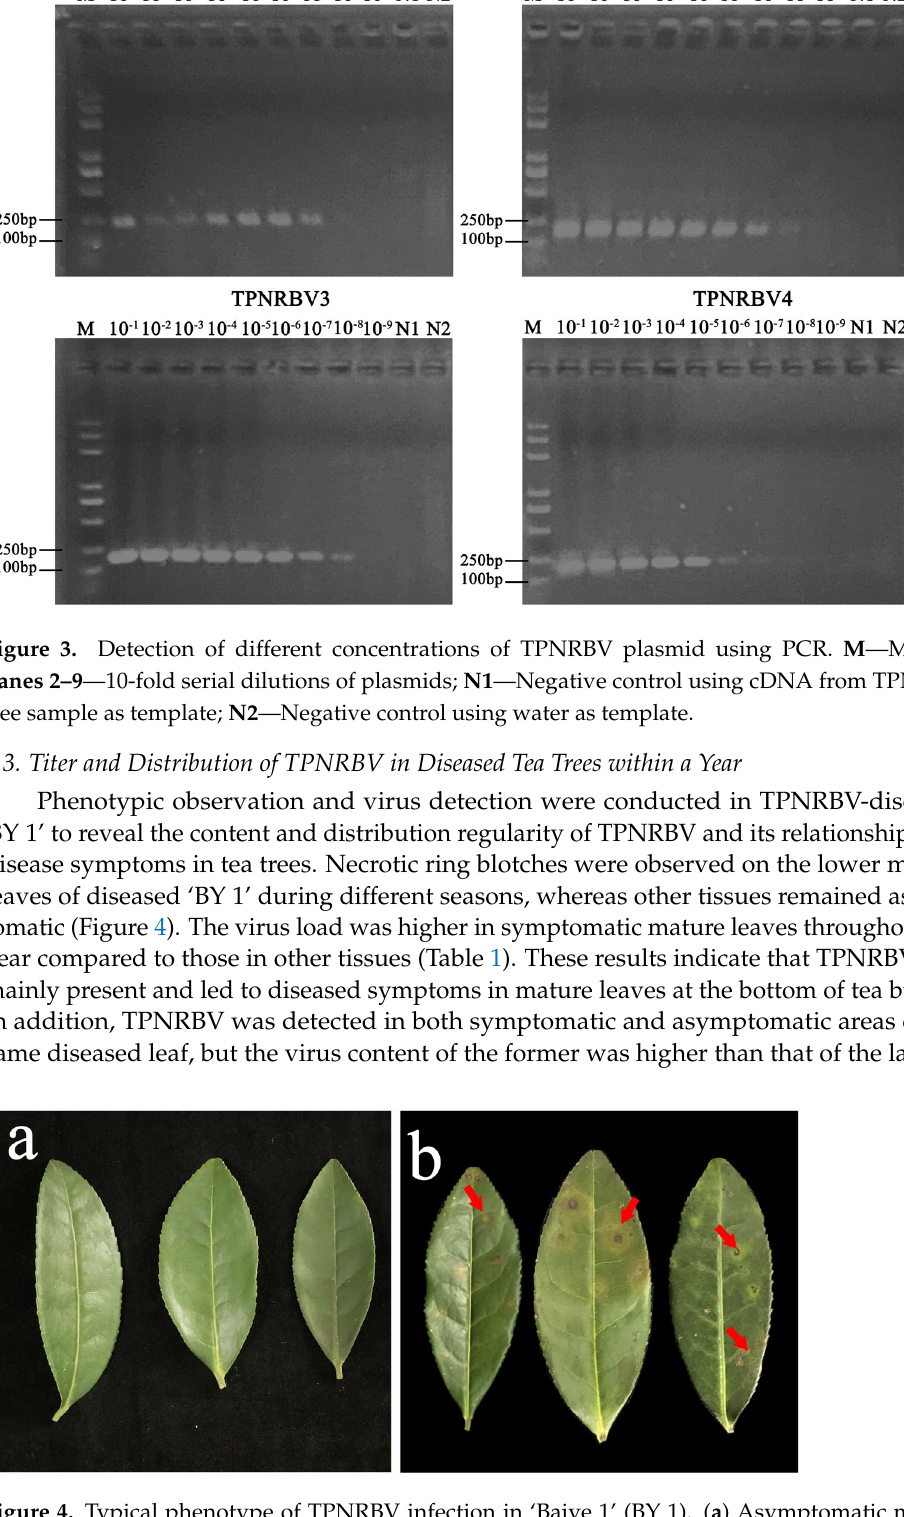
Figure 4. Typical phenotype of TPNRBV infection in ‘Baiye 1’ (BY 1). ( a ) Asymptomatic mature leaves. ( b ) Symptomatic diseased mature leaves.